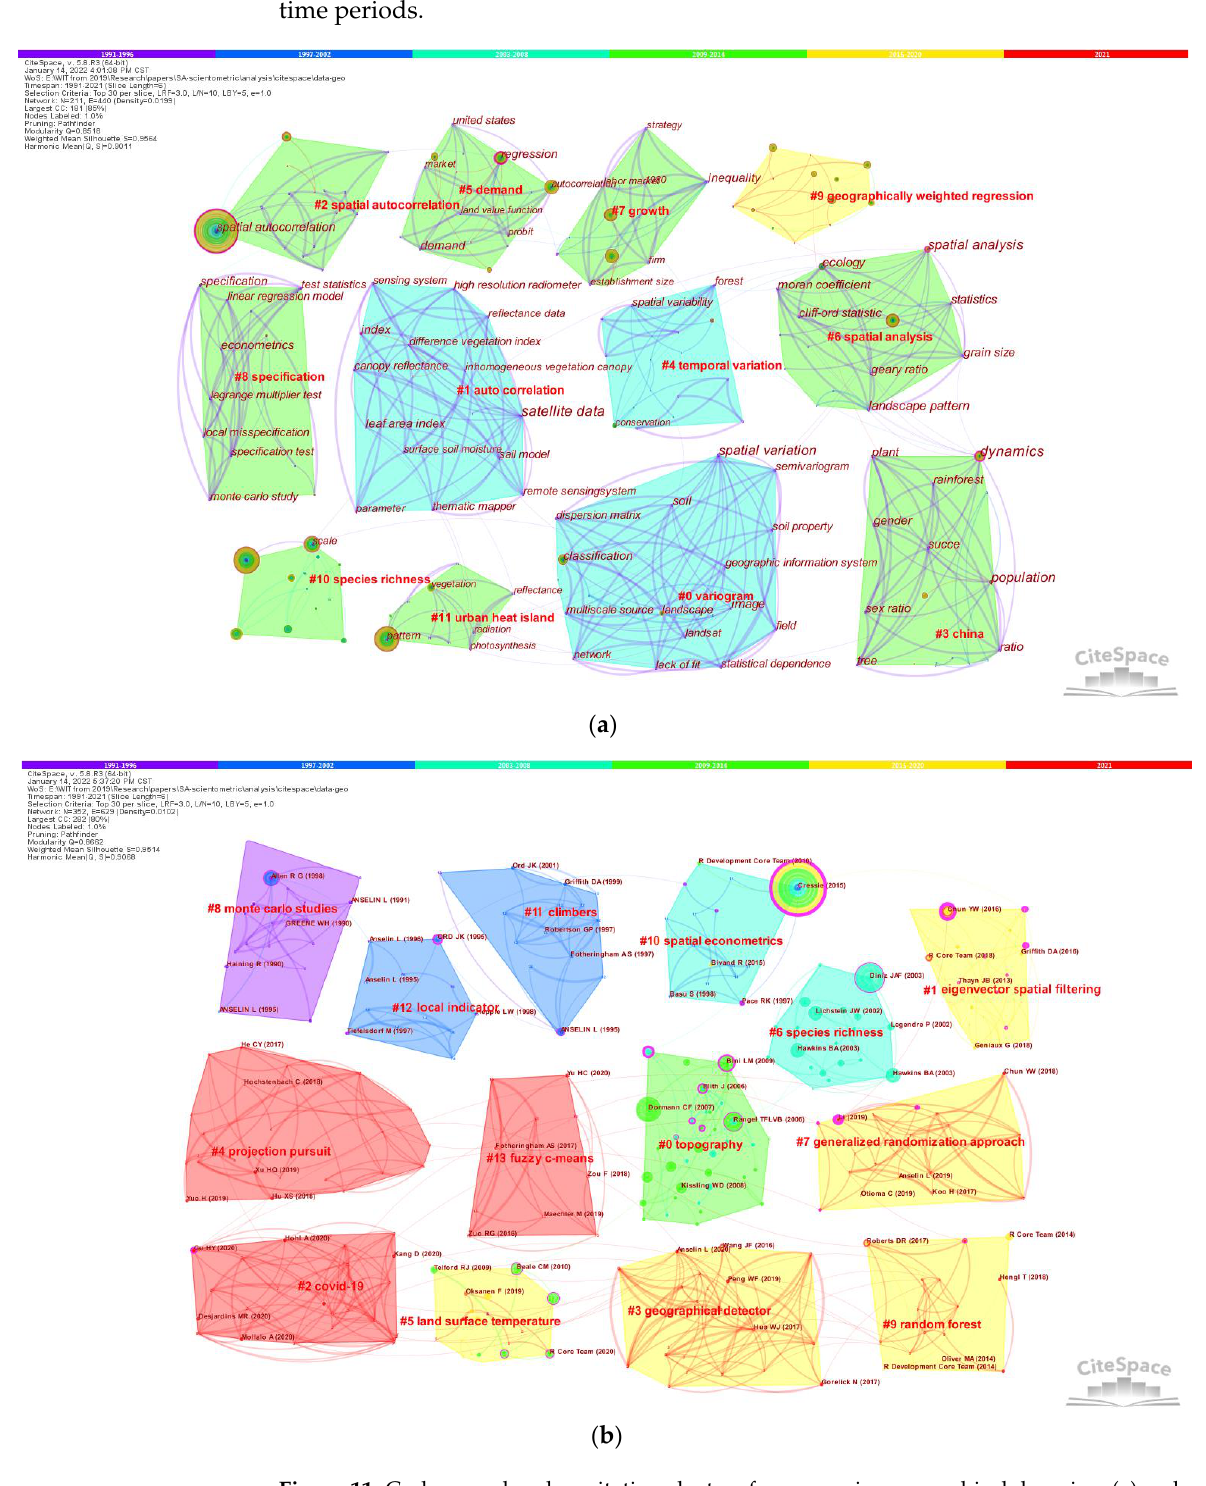
Figure 11. Co-keyword and co-citation clusters for papers in geographical domains. ( a ) co-keyword clusters, and ( b ) co-citation clusters. (Interpretation of nodes, links, and colored convex hull are the same with those in Figure 10.)